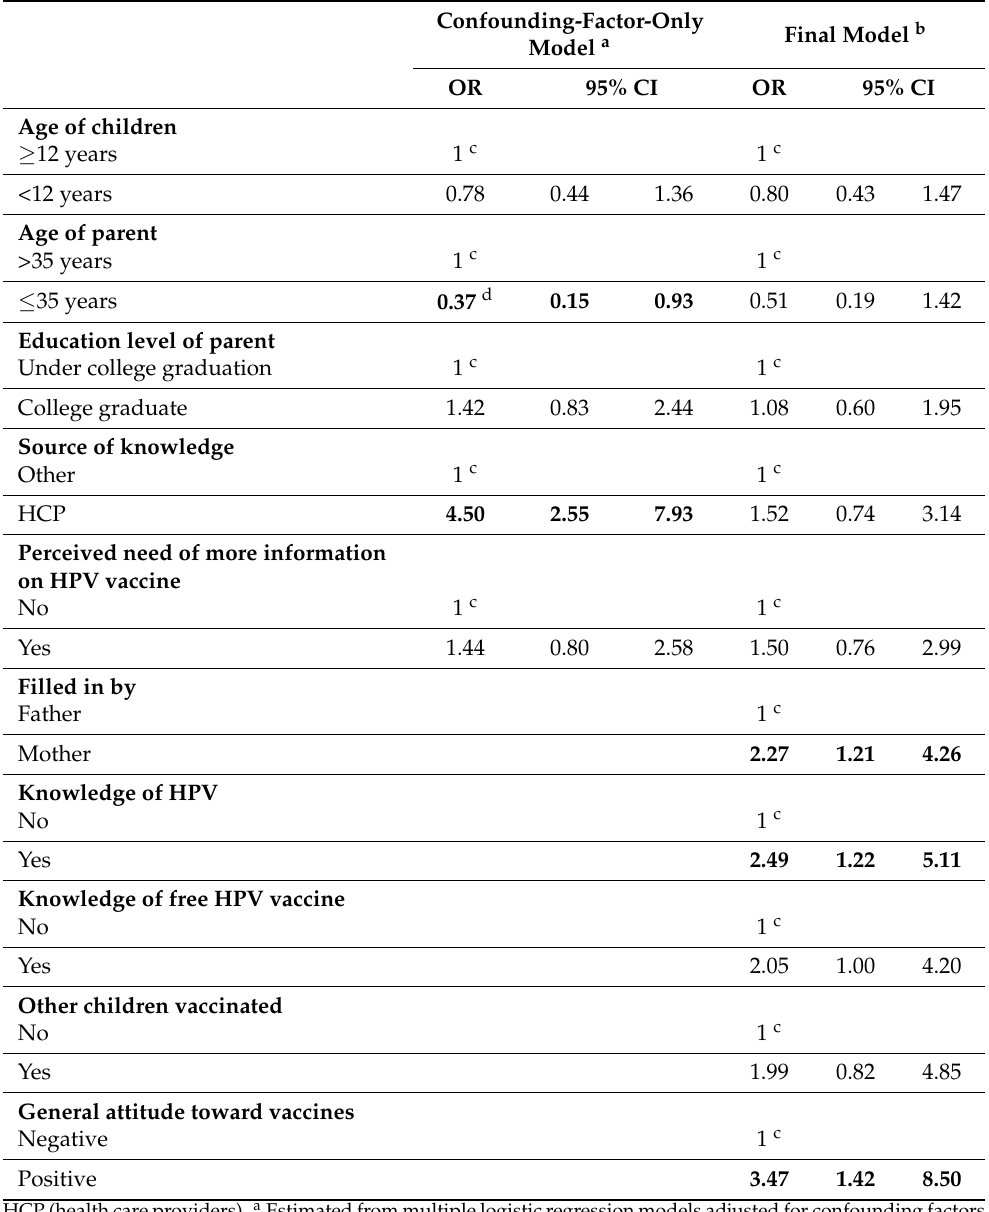
Table 4. Odds ratios (ORs) for a positive attitude toward HPV vaccination and corresponding 95% confidence intervals (CIs) for selected confounding and risk